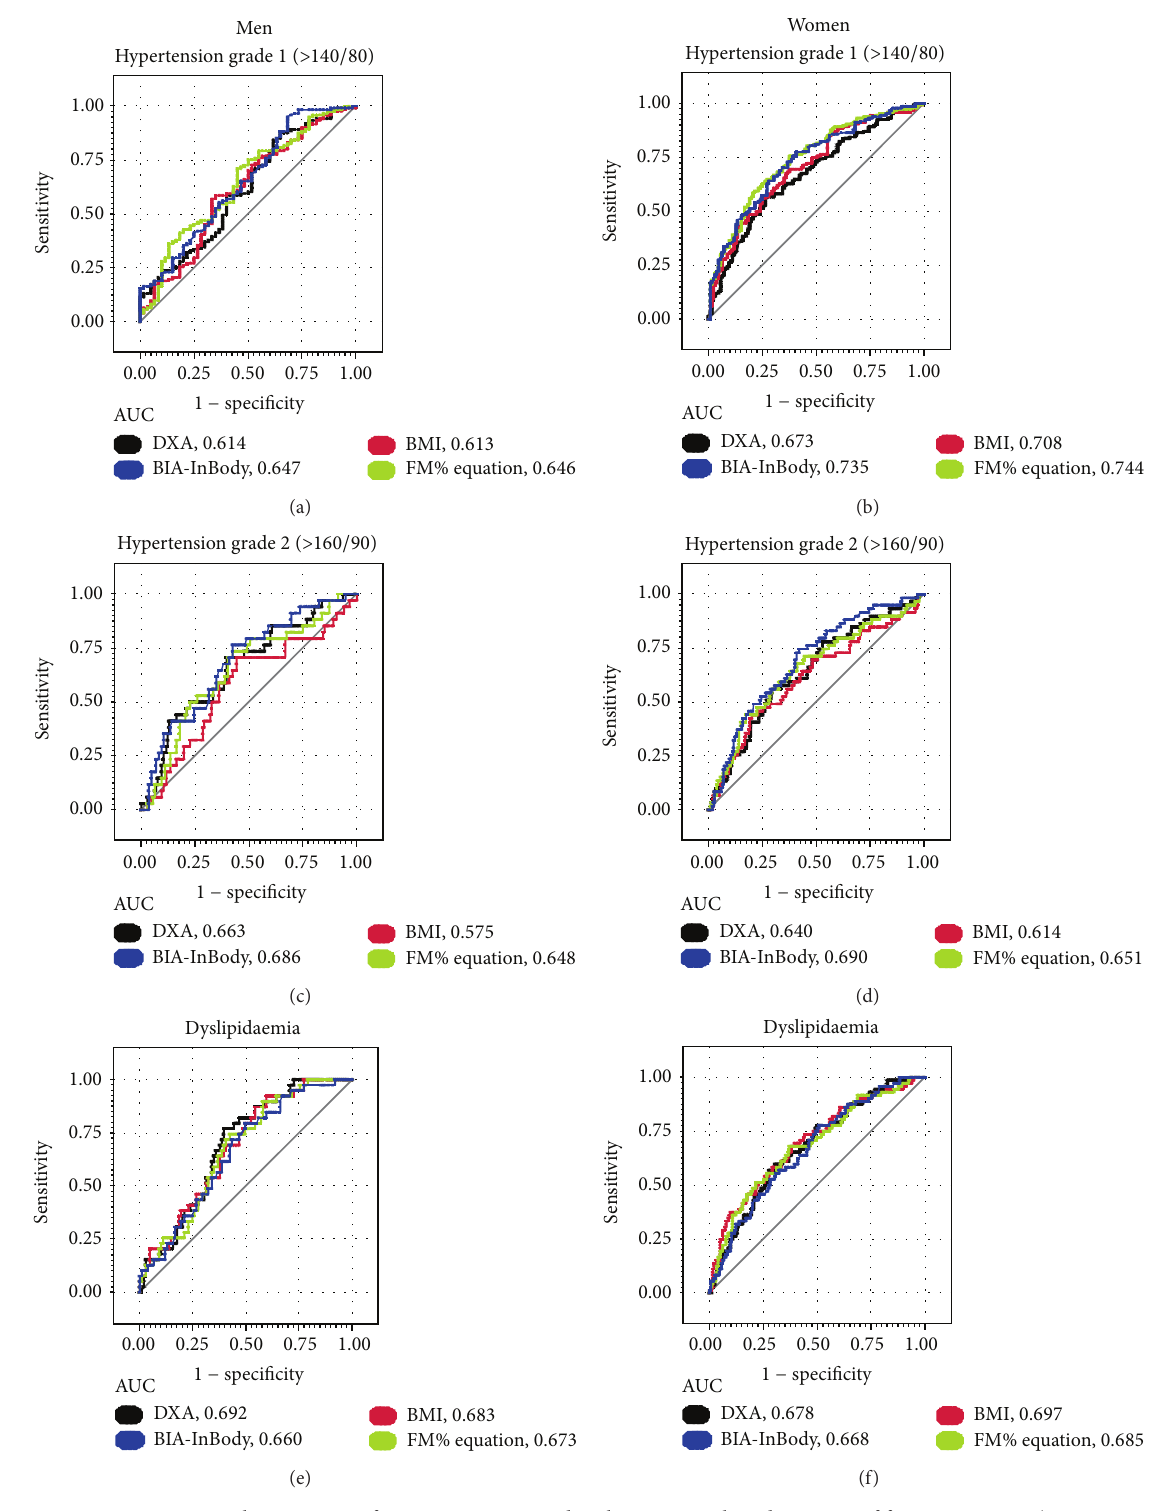
Figure 3: Receiver operating characteristic of DXA, BIA, BMI, and anthropometry-based estimate of fat mass percent (FM%-equation) as predictorsofhypertensionanddyslipidaemia.(a)Indirectcomparisons,theareaundercurve(AUC)fortheanthropometry-basedestimateof fat mass percentage (FM%-equation) is larger than AUC for BMI ( 𝑃 = 0.021 ). (b) AUC for the BIA InBody is larger than for DXA ( 𝑃 < 0.001 ). AUC for FM%-equation is larger than for both DXA and BMI ( 𝑃 < 0.001 ). (c) AUC for BIA InBody is larger than for BMI ( 𝑃 = 0.006 ) as is AUC for the FM%-equation ( 𝑃 < 0.001 ). (d) AUC for the BIA InBody is larger than for DXA and BMI ( 𝑃 < 0.001 ) and also larger than for the FM% equation ( 𝑃 < 0.044 ). AUC for the FM% equation is larger than for BMI ( 𝑃 < 0.001 ). (e) AUC for the FM%-equation is larger than for BIA InBody ( 𝑃 = 0.013 ). (f) There are no significant differences in areas under curve (AUC) for the different